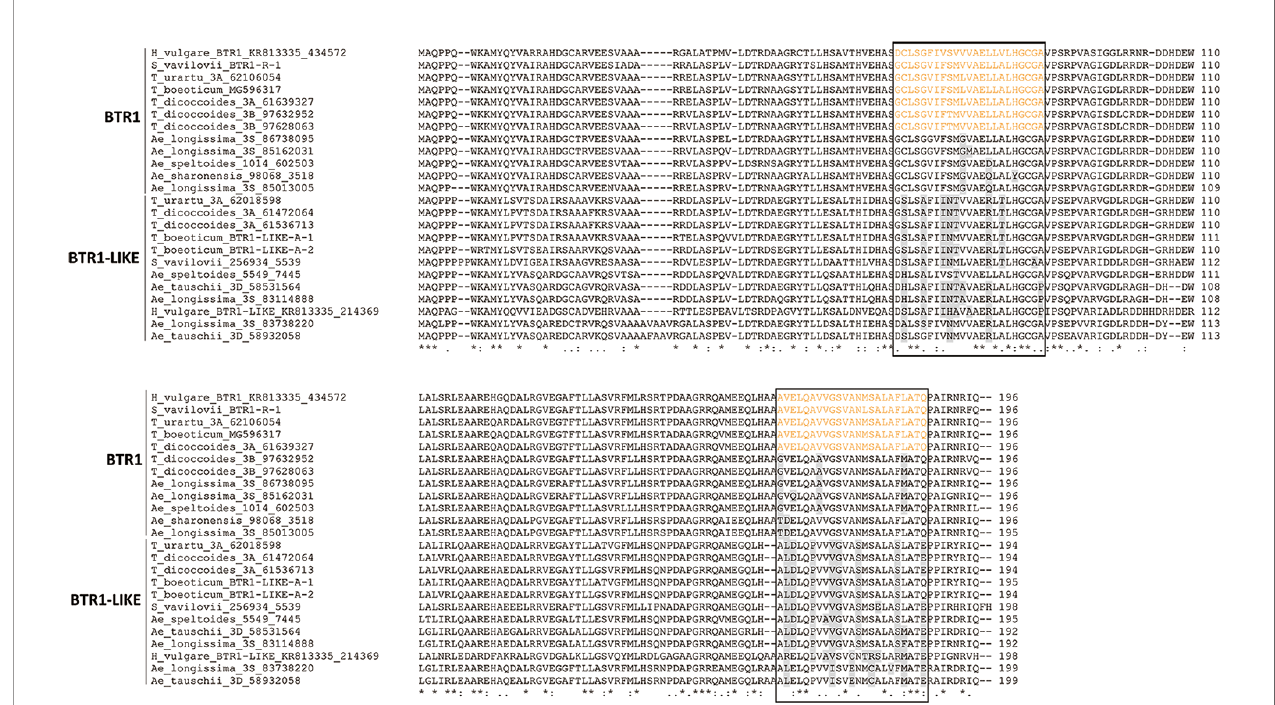
FIGURE 4 | Alignment of deduced Triticeae BTR1 and BTR1-like polypeptides. The two predicted transmembrane helix regions are shown boxed, and the transmembrane helices are colored orange. Variable residues in the transmembrane helices are colored gray.